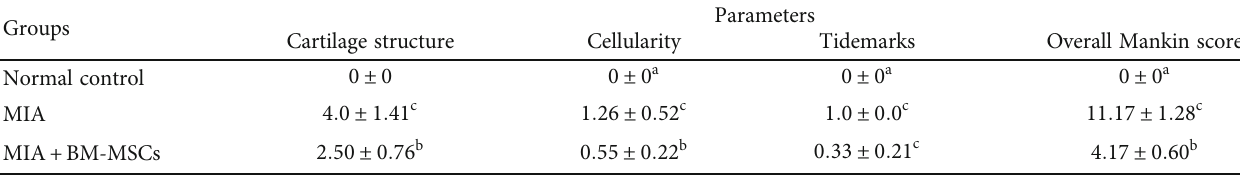
Table 5: Mankin scoring of the cartilage among experimental groups.